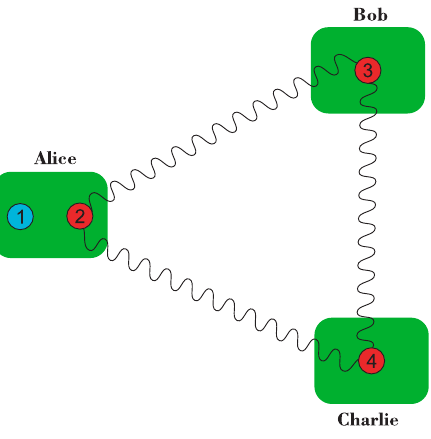
Figure 3. A possible scheme to perform quantum teleportation of a qubit state by using a three-particle entangled state as the quantum channel.